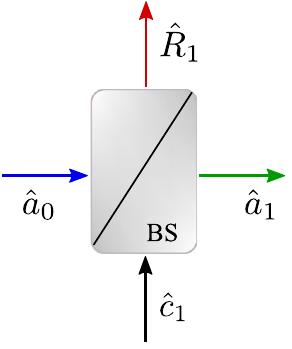
Figure 1. Each loss center can be simulated with a BS where operator ˆ a 0 enters into the BS and mixes with noise ˆ c 1 . operator ˆ a 1 goes out of it and the BS reflects operator ˆ R 1